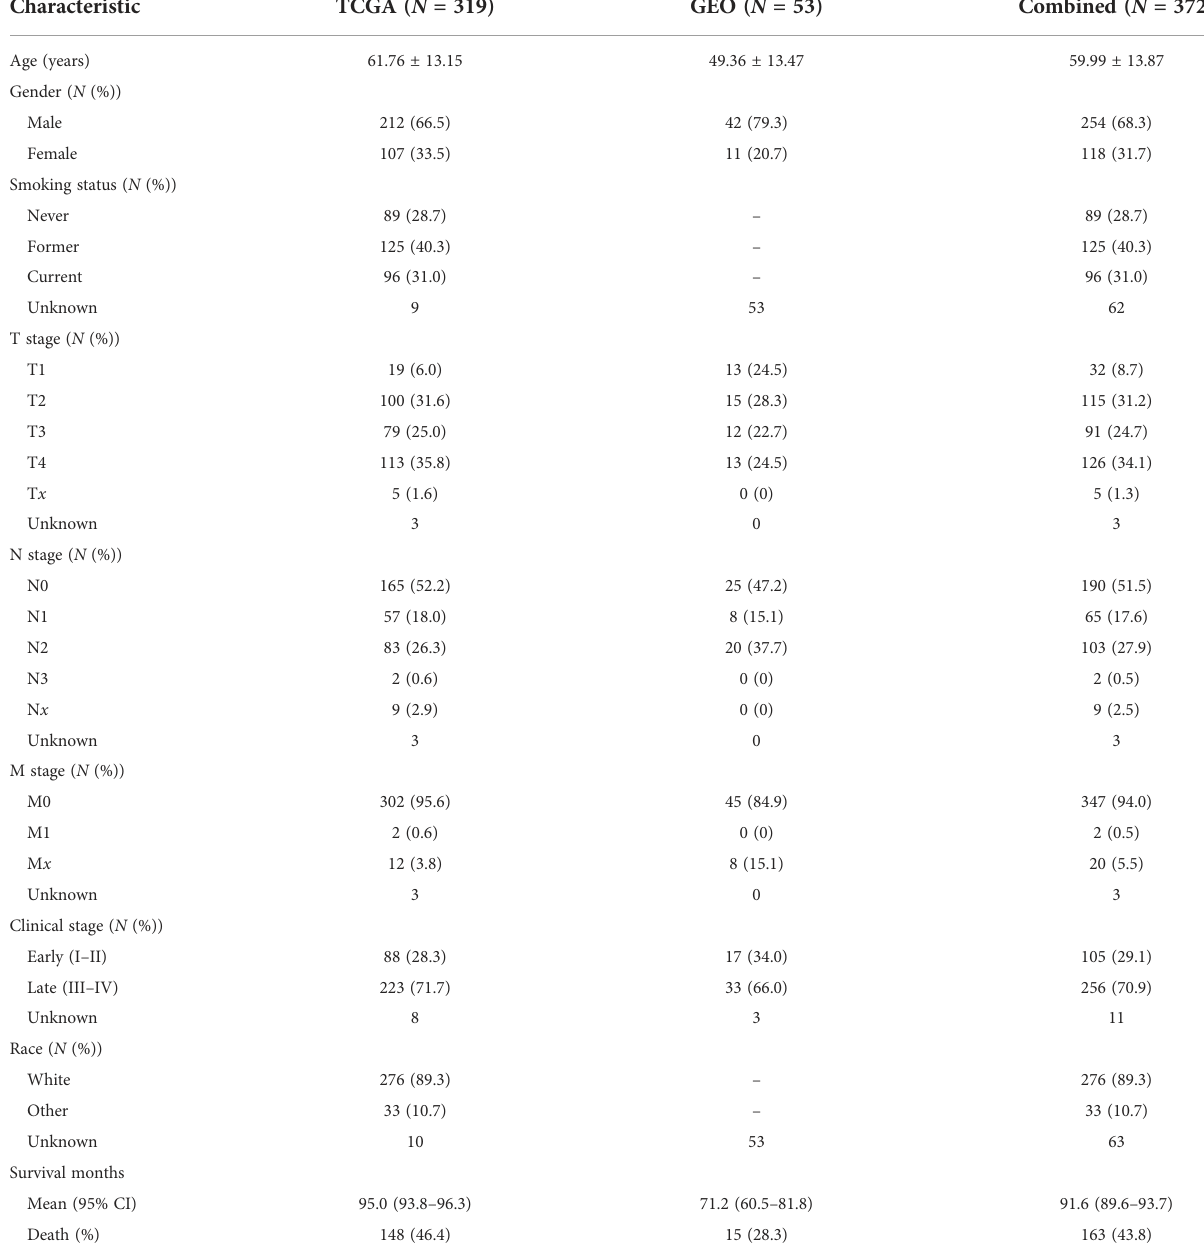
TABLE 1 Demographic and clinical descriptions of subjects in the discovery phase (TCGA), the validation phase (GEO), and the combined dataset, respectively.